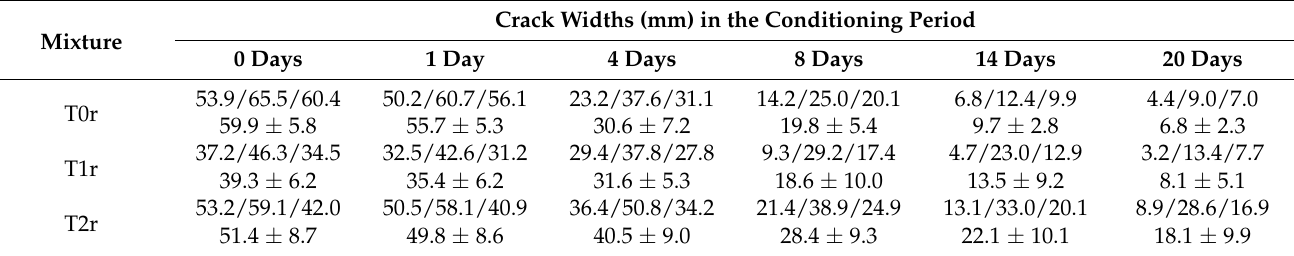
Table 4. Crack progress in the specimens and mean crack widths for